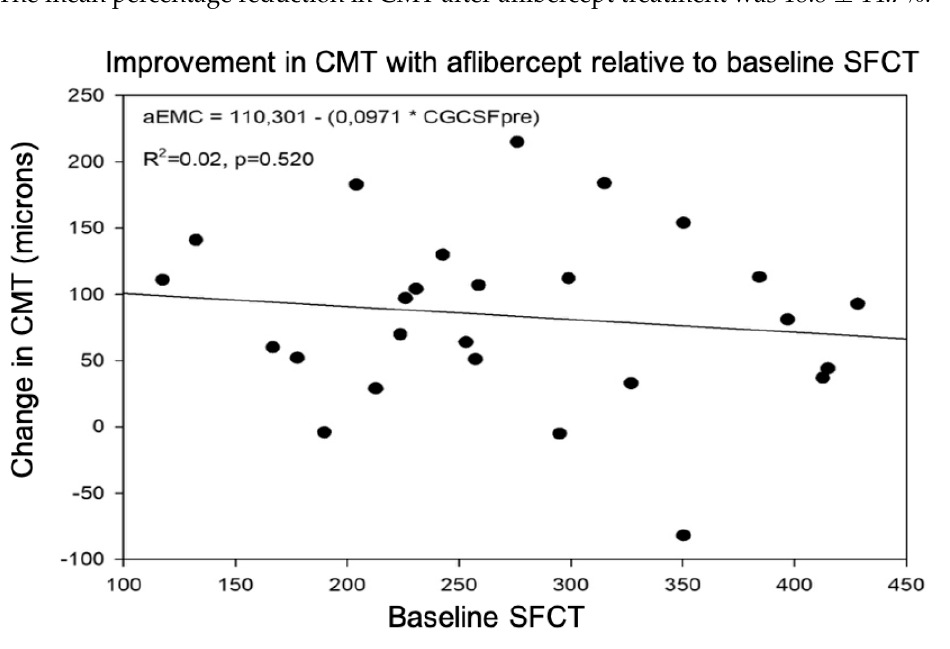
Table 1. Results of treatment with aflibercept and dexamethasone implants.